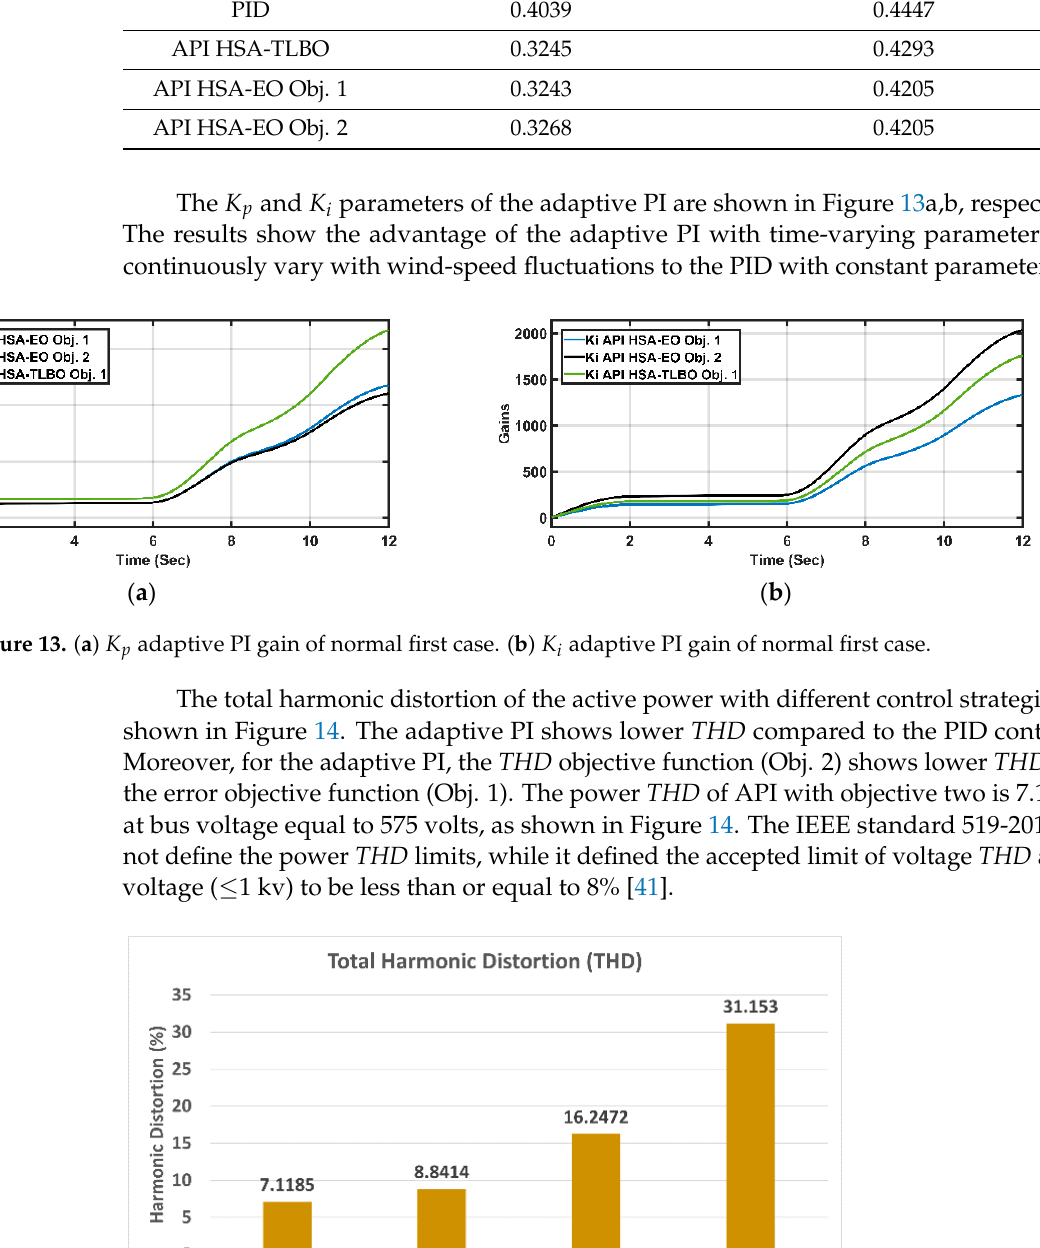
Figure 15. Wind-speed profile of normal second case. ( a ) ( b ) Figure 16. ( a ) Active power responses of normal second case. ( b ) Blade-angle responses of normal second case.